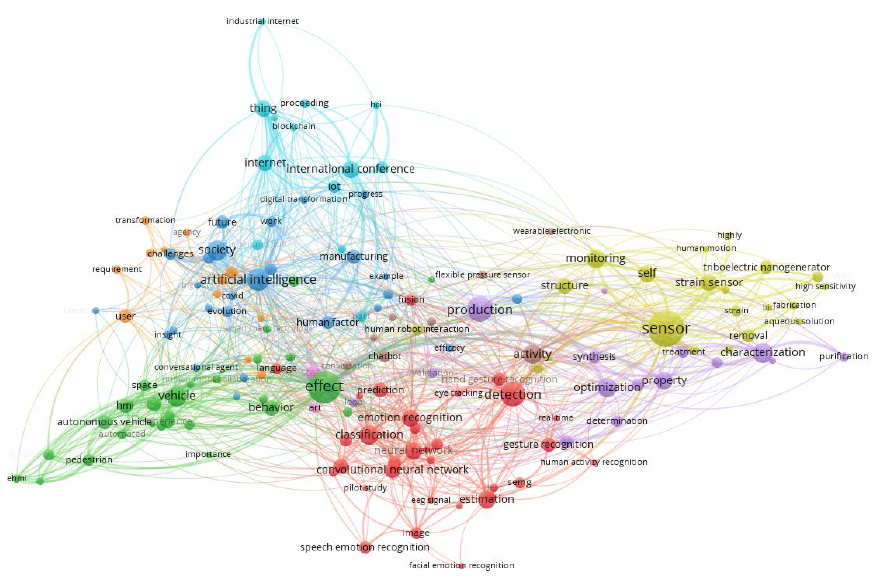
Figure 16. Term co-occurrence map based on provided publications Scopus.